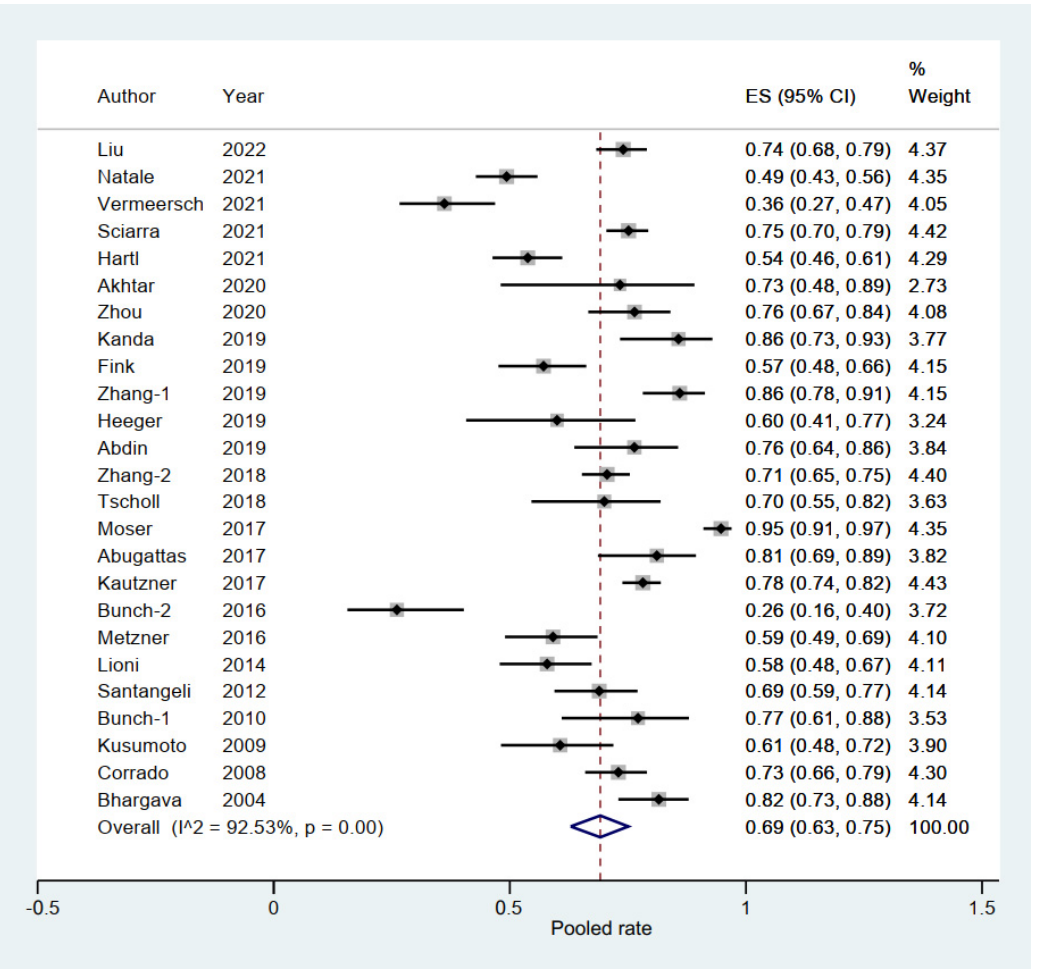
Figure 5. Forest plot of the pooled rate of freedom from AF in the elderly group [6,10–17,19–27,29–35]. The line of equity refers to the pooled result of eligible studies in the forest plots. AF: atrial fibrillation. Table 2. Subgroup analysis of the rate of freedom from atrial fibrillation in the elderly